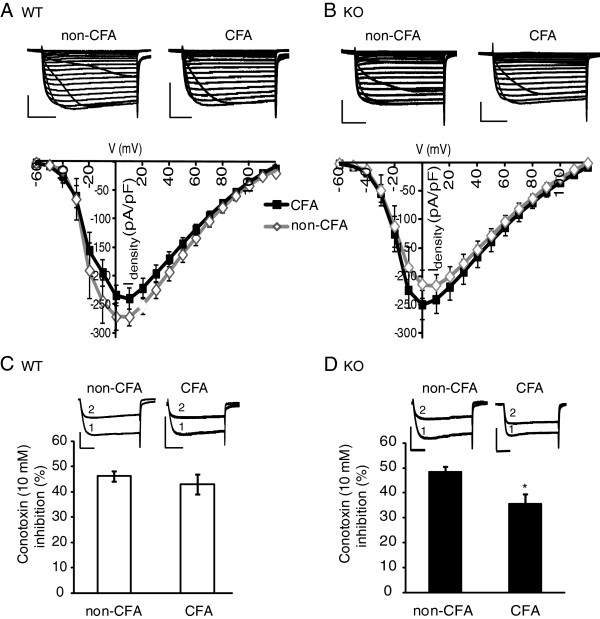
Inflammatory pain altered VDCC-density and current-type contribution in β-arrestin 2 knockout, but not wildtype mice. A and B. The current–voltage relationship recorded from either WT (A) or KO (B) neurons was not altered by CFA (3 days post-injection). Exemplar currents from WT and KO neurons of the contralateral (non-CFA) and ipsilateral (CFA) sides are shown above the current–voltage graphs depicting the maximum current induced by each voltage and corrected for cell capacitance. Vertical scalebar =20 ms and horizontal scalebar = 0.5 pA, n = 10–16. C and D. The contribution of N-type VDCCs to the total current in WT neurons was not altered by CFA (C) but was reduced in DRG neurons from KO mice (D; F (3,25) = 4.57, n = 6–7). Exemplar currents show VDCCs measured in the absence (1) and presence (2) of the selective N-type inhibitor, ϖ -Conotoxin GV1A (10 μM). * p < 0.05.